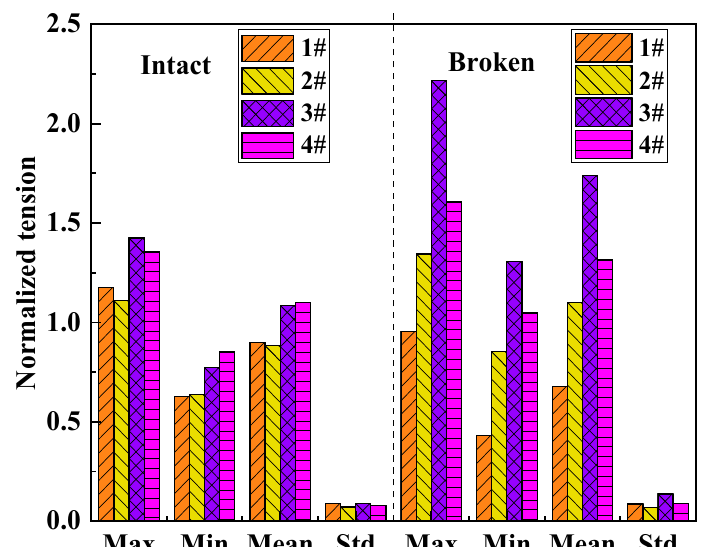
Figure 16. Comparison of normalized tension statistics.